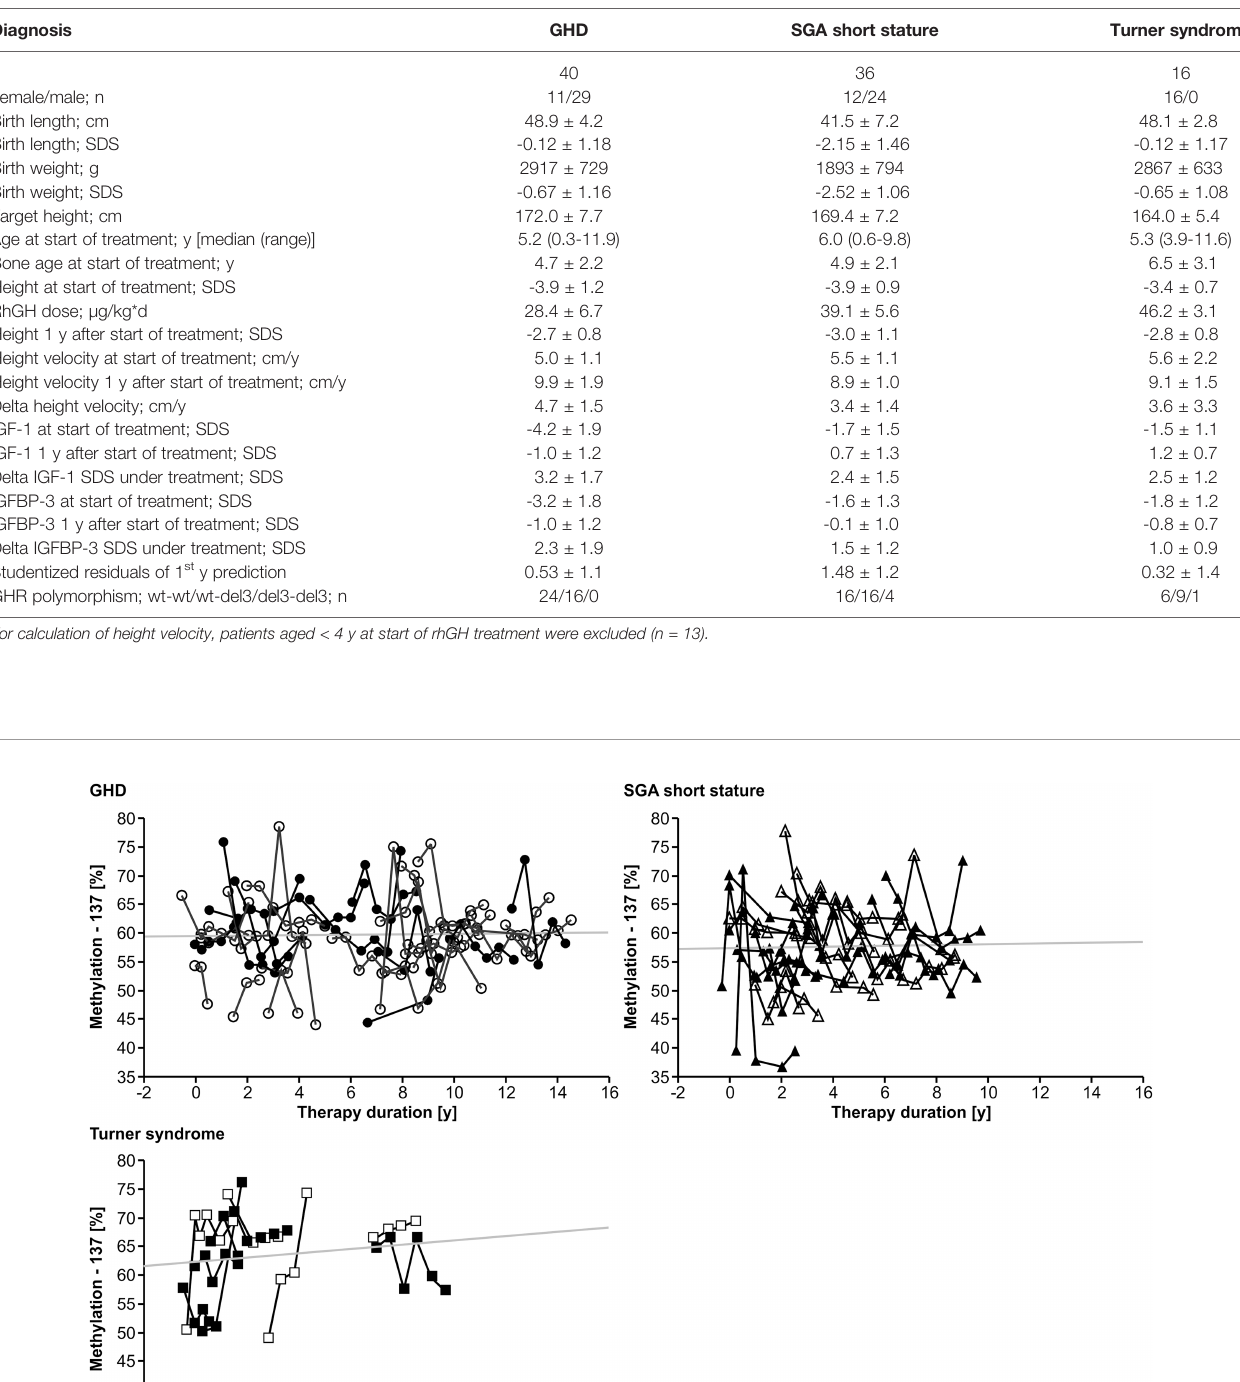
TABLE 1 | Clinical characteristics and GHR polymorphism status of the patients (mean ±